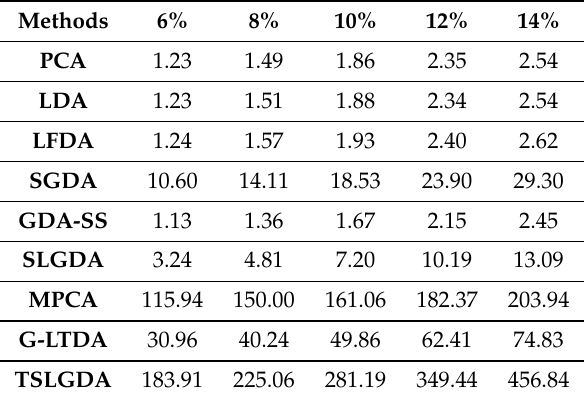
Table 6. Execution time (in seconds) of different methods for the Indian Pines data with different training